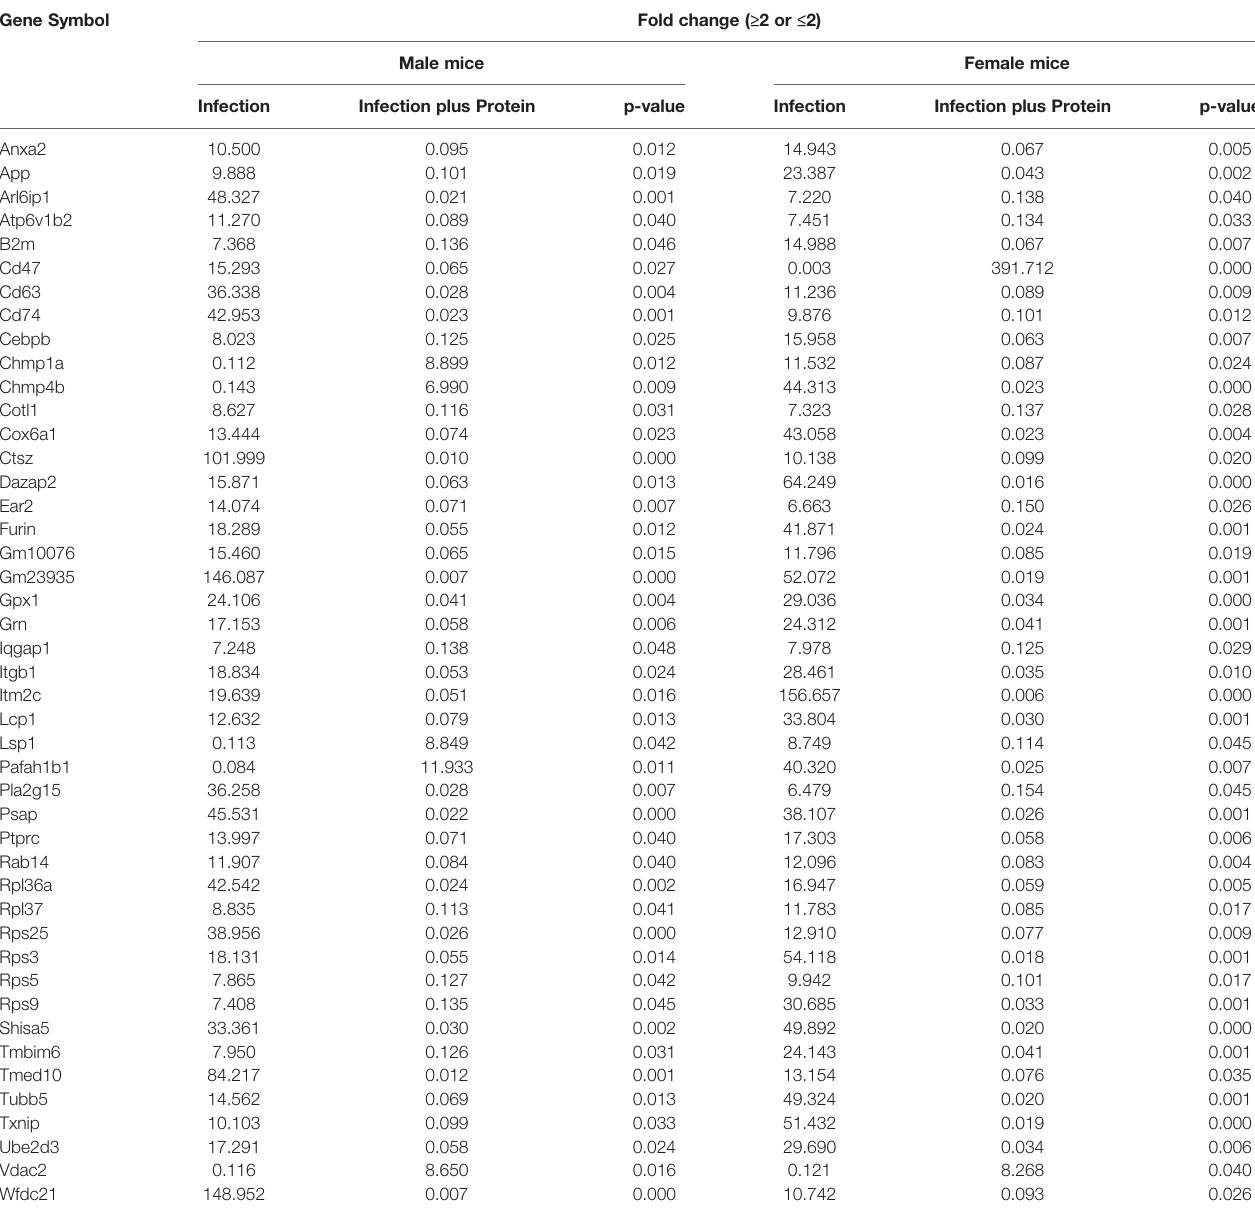
TABLE 2 | Relative content ( ≥ 2-fold or ≤ 2-fold) of genes found to be in common in KO male vs. female (M/F) mice and vice versa after infection and infection plus SP- A2(1A 0 ) rescue are shown. Gene Symbol Fold change ( ≥ 2 or ≤ 2) Male mice Female mice Infection Infection plus Protein p-value Infection Infection plus Protein p-value